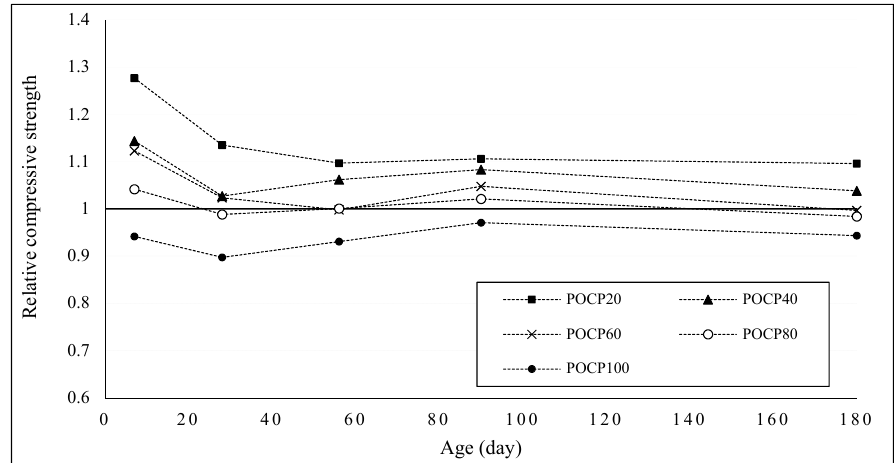
Figure 13. 28-day compressive strength of POC and POCP concretes.